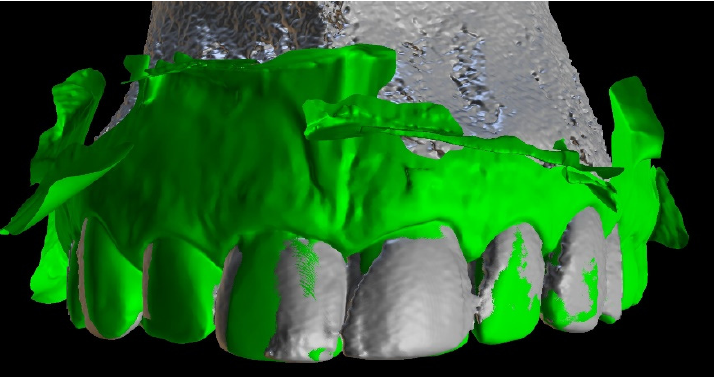
Figure 3. Image presenting aligned files of patient’s CBCT data and intraoral scan.